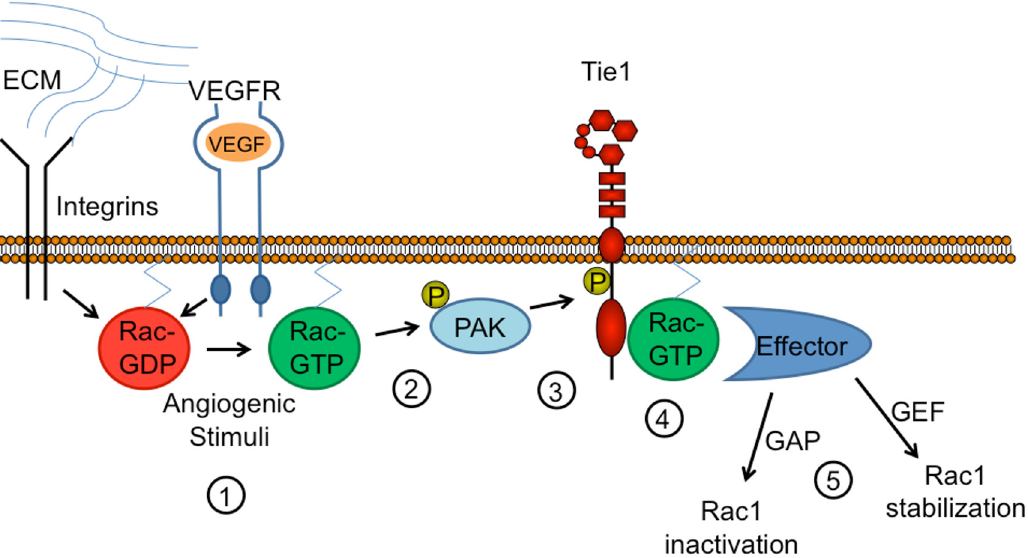
Fig 6. Proposed model for Tie1-T794 phosphorylation by Rac1/PAK1 and modulation of Rac1 signaling. 1) Angiogenic stimuli (e.g., extracellular matrix (ECM)-mediated integrin activation, VEGF stimulation, etc.) induce Rac1 activation (Rac1-GTP). 2) Rac1-GTP activates PAK1, resulting in PAK1 autophosphorylation. 3) PAK1 phosphorylates Tie1 on T794. 4) Rac1 associates with Tie1-pT794. 5) Rac1 association with Tie1 facilitates interaction with effector molecules that either stabilize it in its active GTP-bound form or mediate GTP hydrolysis and subsequent Rac1 inactivation. Mutation of Tie1-T794 therefore disrupts Rac1 signaling and inhibits proper angiogenesis and capillary